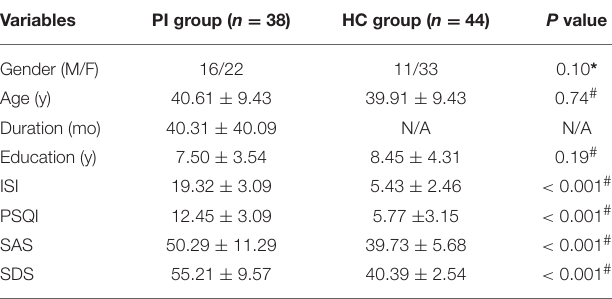
TABLE 1 | Demographic and scale data of all study